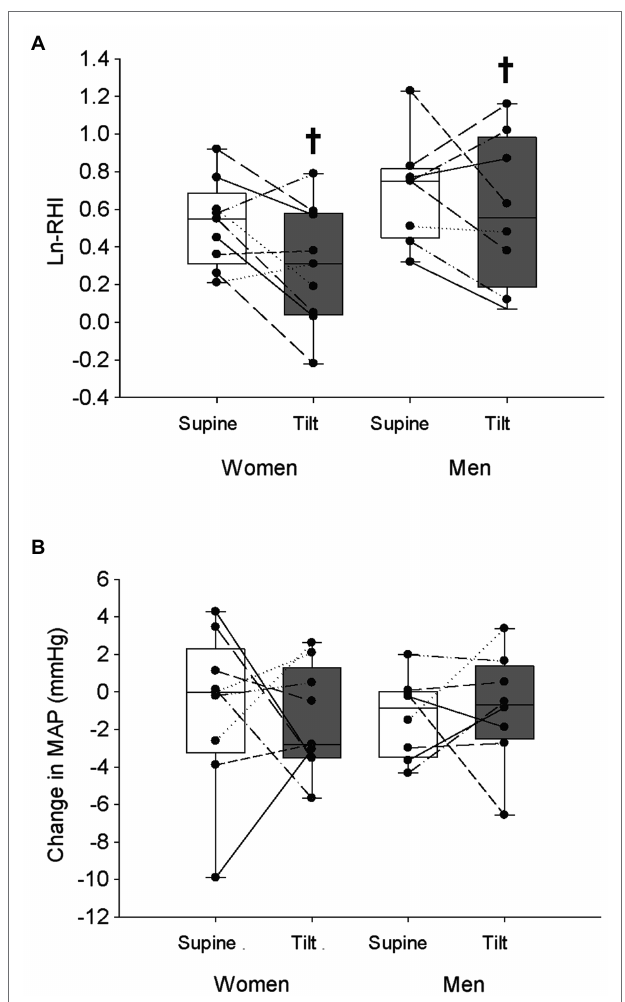
FIGURE 3 | Natural logarithm of the reactive hyperemia index (LnRHI; A ) and the change in MAP (B) from the beginning of each trial to the time of maximal hyperemic response is shown in women and men in the supine and tilted postures. White bars indicate supine posture, grey bars indicate upright posture. † Indicates a main effect of posture ( p <